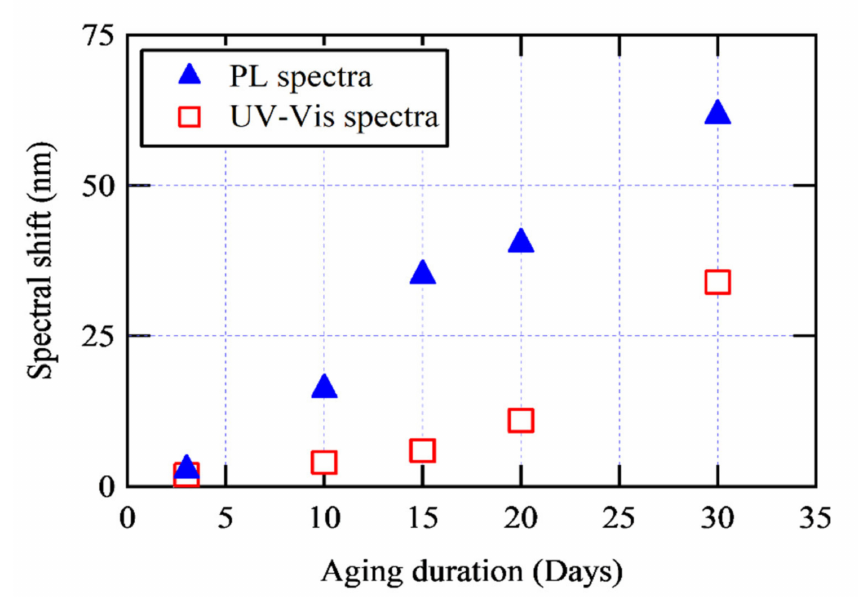
Figure 12. The spectral shift against aging duration for PL and UV-Vis